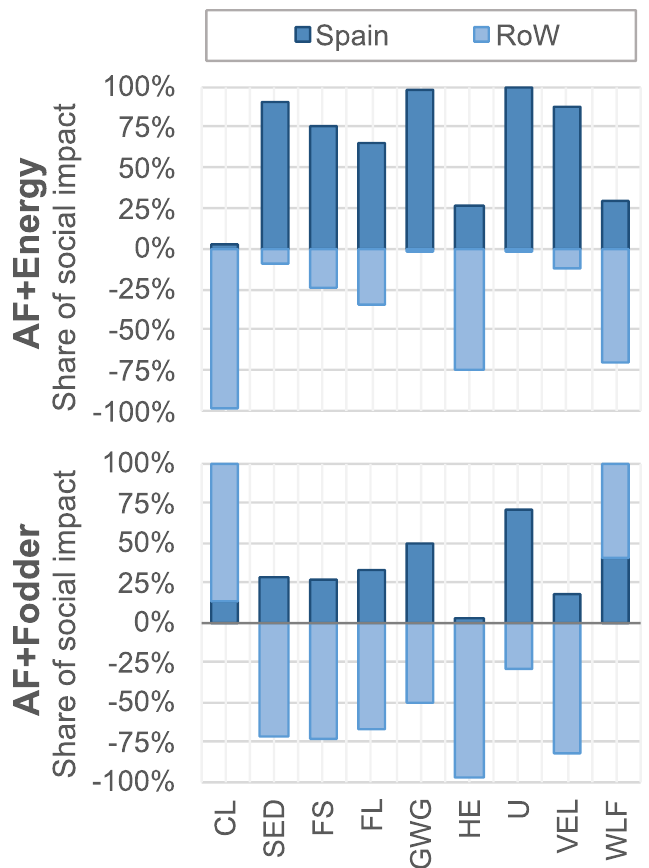
Figure 5. Breakdown of impact origins by domestic (Spain) and foreign (Rest of the World, RoW) activities. Abbreviations: CL—Child Labor; SED—Sector contribution to Economic Development; FS—Fair Salary; FL—frequency of Forced Labor; GWG—Gender Wage Gap; HE—Health Expenditure; U—Unemployment; VEL—Violations of Employment Laws and regulations; WLF—Women in the sectoral Labor Force. Note that SED is the only positive indicator (higher is better), and all other indicators should be interpreted as “lower is